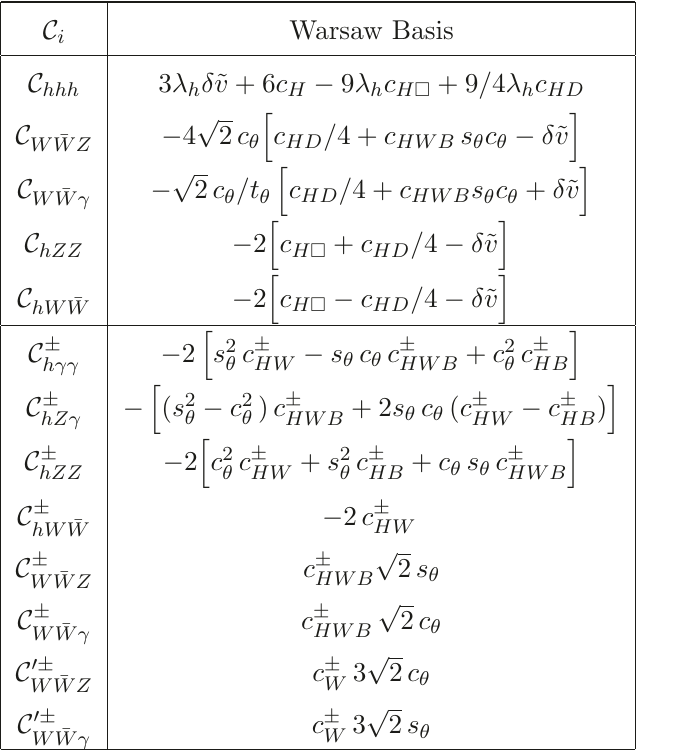
± , and the dimension six SMEFT in the i C i C